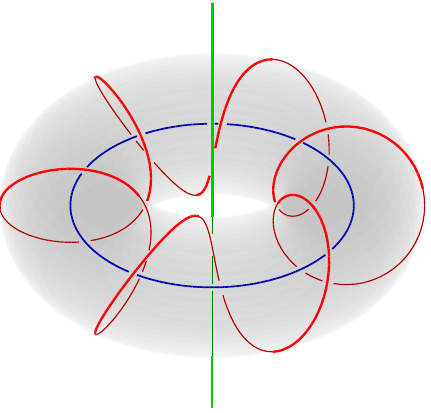
Figure 4. Depiction of an L (1 ; 1 ; 1) link consisting of the blue, red, and green circles. The (1 ; 6) solid gray torus is there for visualization